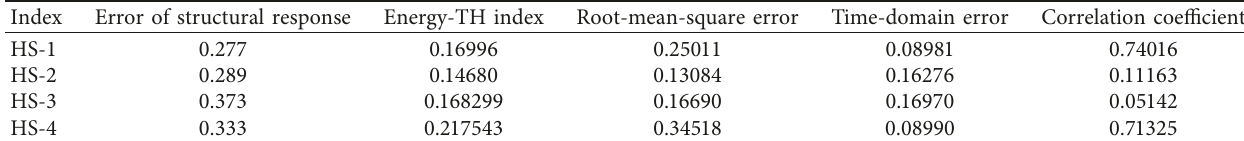
Table 6: Structural response error and other indices of